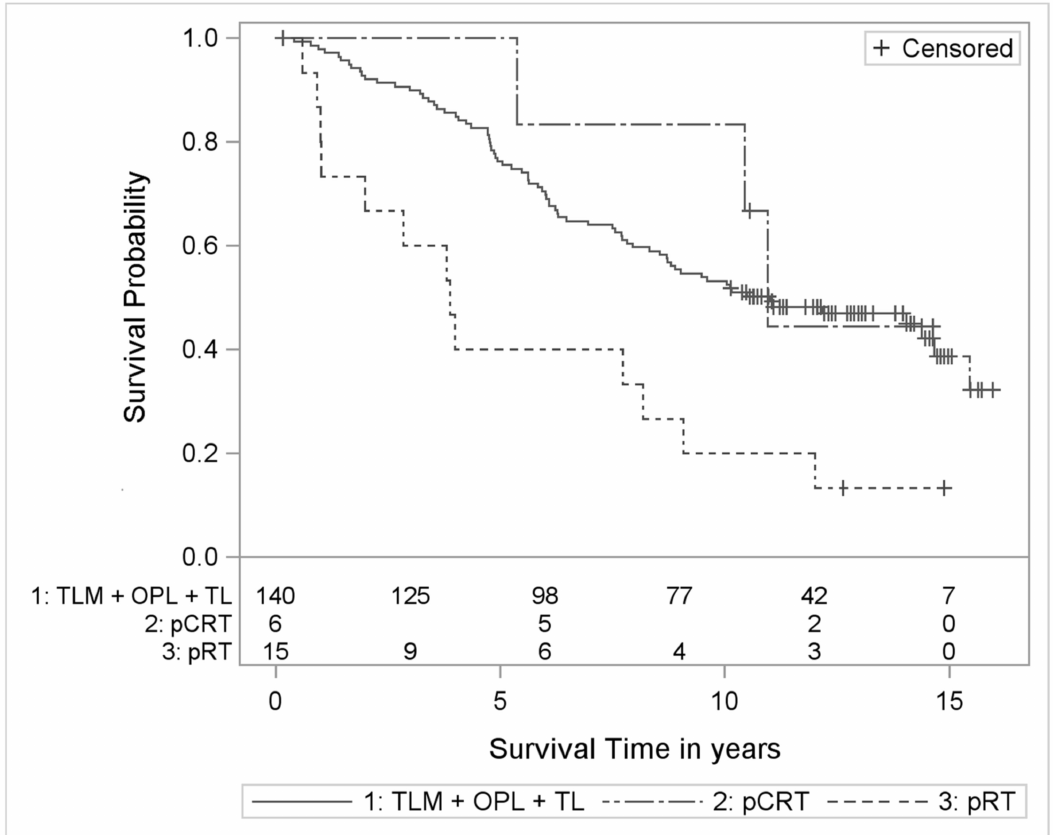
Figure 1. Kaplan-Meier curves with numbers at risk of T2 laryngeal cancer patients treated with pCRT or pRT compared to surgery. TLM: transoral laser microsurgery, OPL: open partial laryngectomy, TL: total laryngectomy, pCRT: primary radiochemotherapy, pRT: primary